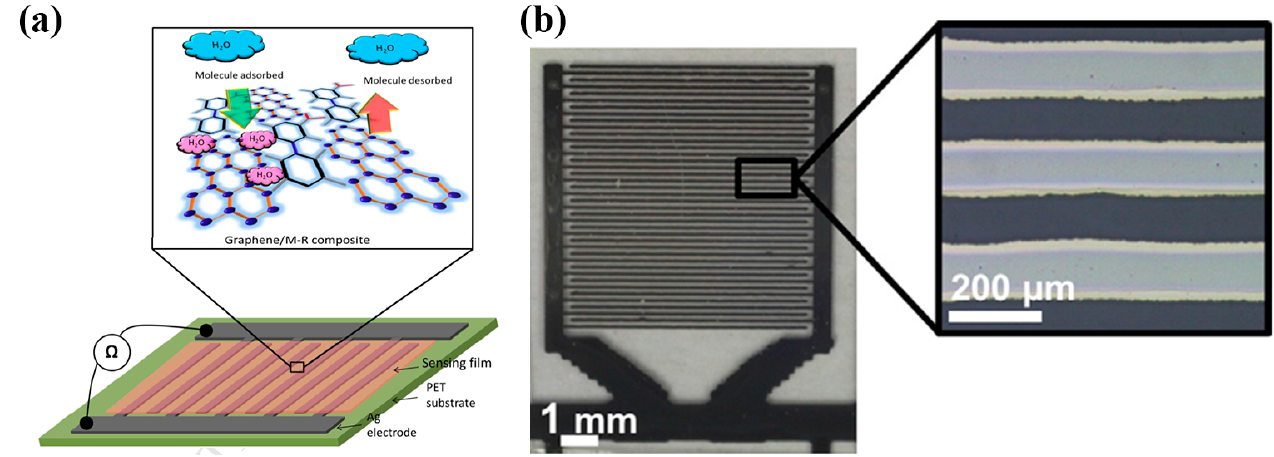
Figure 12. ( a ) Graphene/methyl-red composite sensor printed on PET substrate. The sensor exhibits both resistive and capacitive response to humidity variations (reproduced with permission from [20], copyright 2016, Elesevier); ( b ) An inkjet-printed capacitor coated with a protective Parylene-C film on PET (reproduced with permission from [39] copyright 2013, Elsevier).